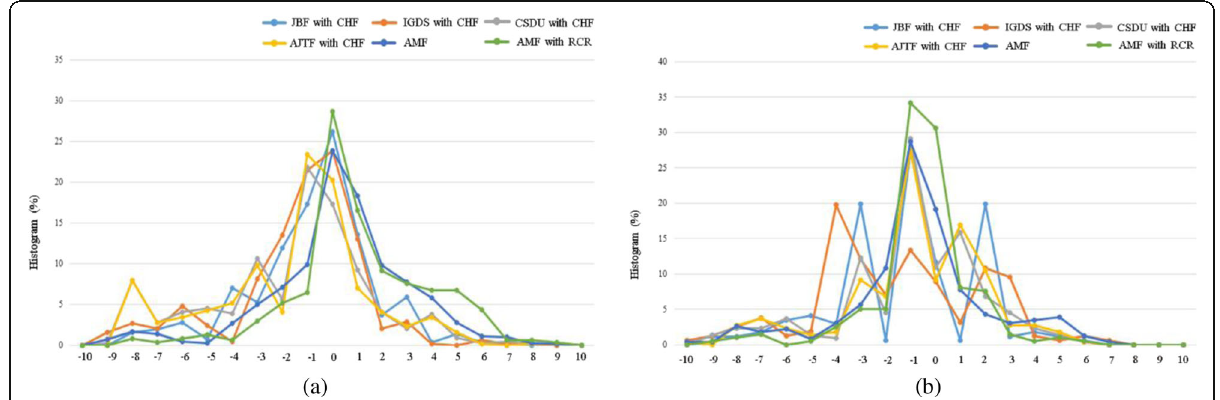
Fig. 10 Results of the enhanced depth map quality metric: a horizontal disparity and b vertical